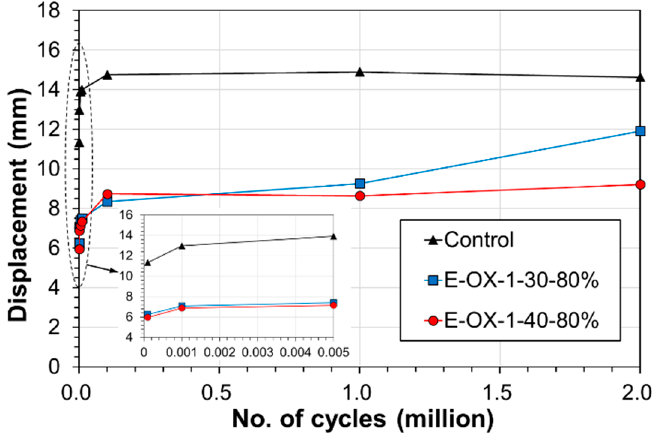
Figure 5. Variation of mid-span deflection during fatigue loading at upper load limit.